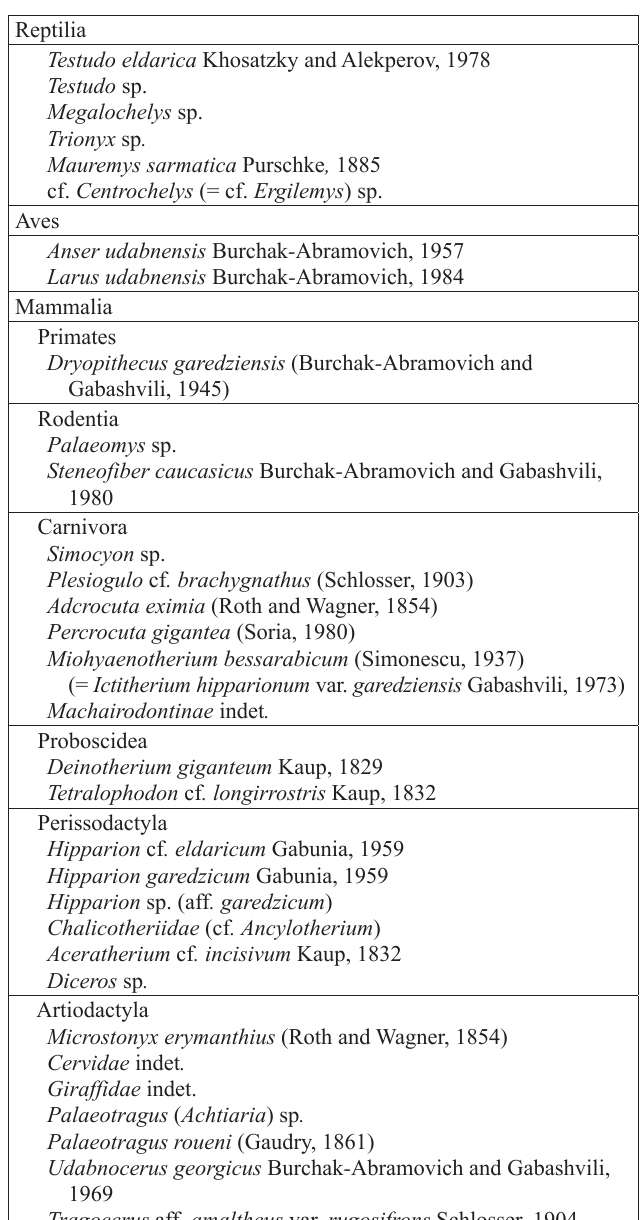
Table 3. Composite faunal list of Udabno. The list is compiled from: Gabunia et al. 2001; Gabunia 1959; Vangengeim et al. 1989; Mela dze 1985; Chkhikvadze and Amiranashvili 1996; Chkhikvadze et al. 2000, Tsiskarishvili 1987; Bakradze and Chkhikvadze 1984; Burchak-Abramov- ich and Gabashvili 1945, 1946, 1980, 1984; Burchak-Abramovich